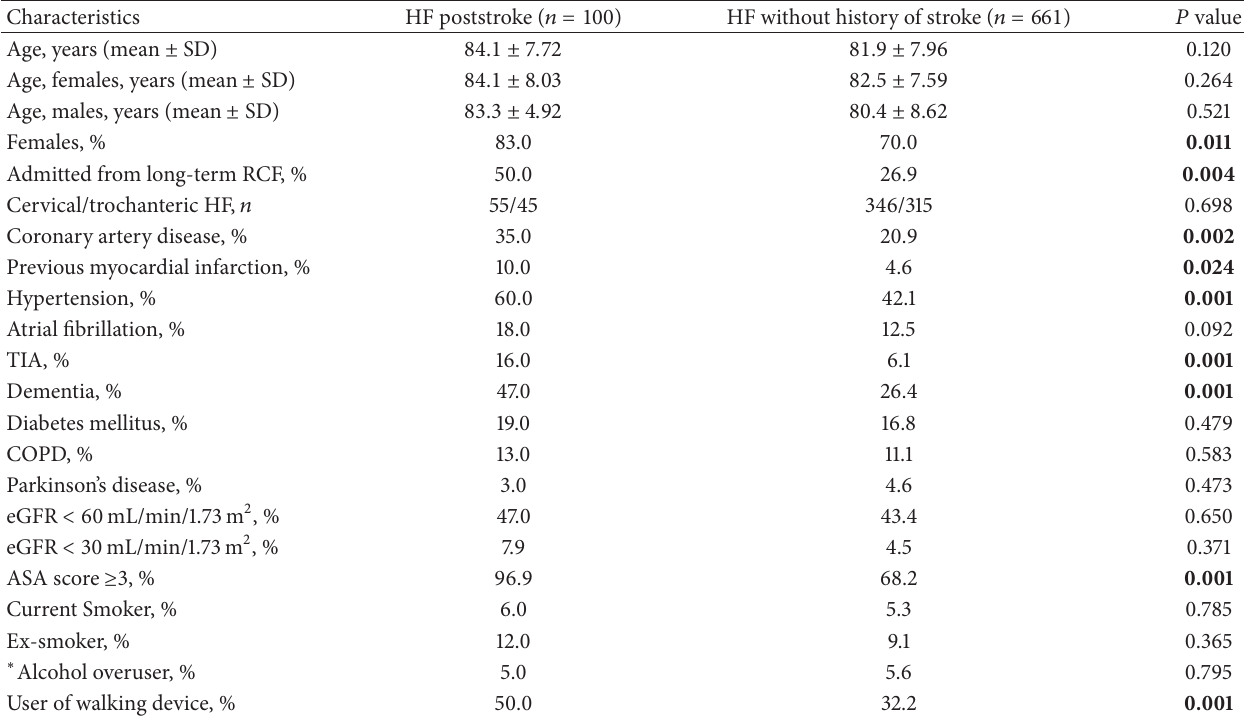
Table 1: Sociodemographic and clinical characteristics in older hip fracture patients with and without history of stroke.